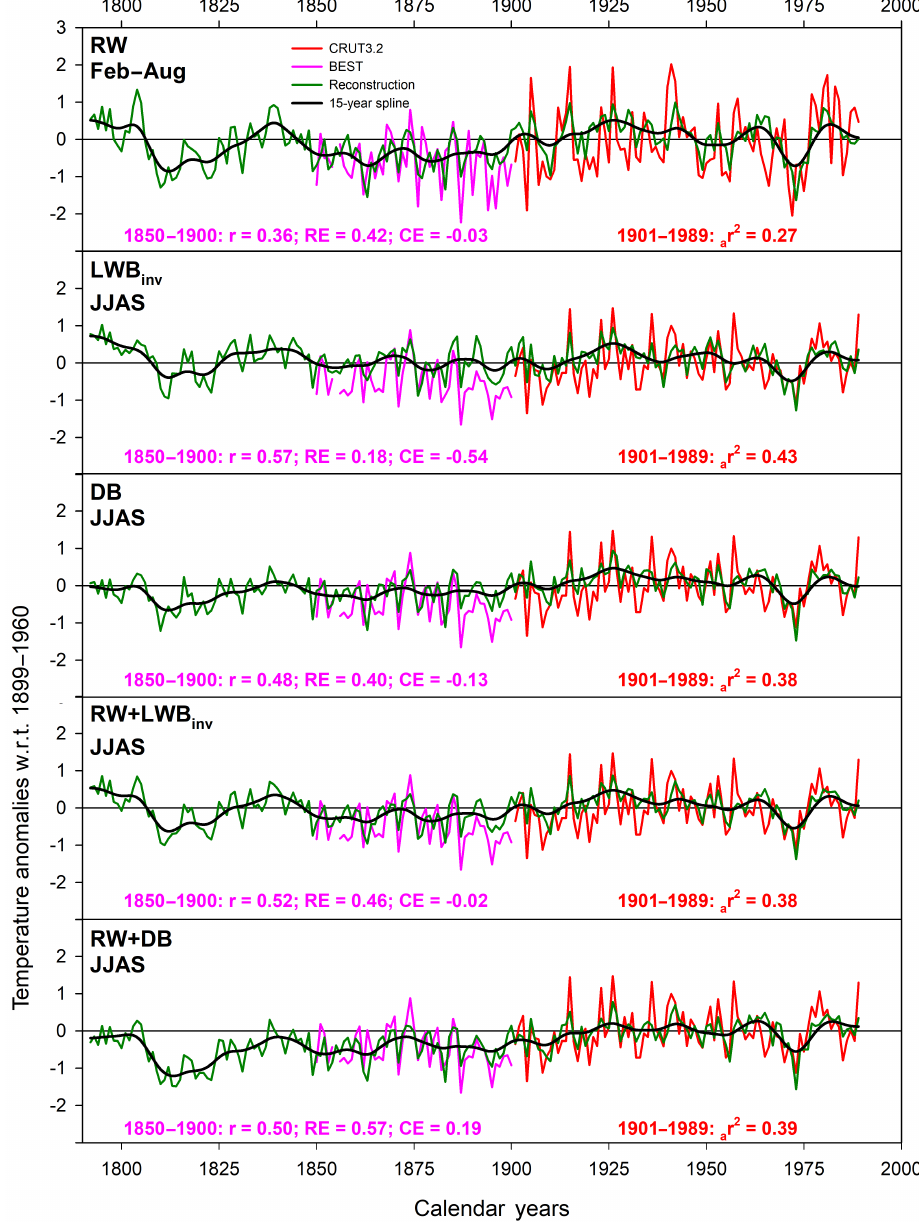
Figure 3. Illustration of the various PC regression experiments performed herein, with each reconstruction model compared with June– September (Table 3). February–August is shown for RW as that was the reconstructed season in Wiles et al. (2014). Full period calibration is performed on the 1901–1989 period (Table 3 – CRU TS 3.24) while validation (Pearson’s correlation coefficient, r ; reduction of error, RE; and coefficient of efficiency, CE) is undertaken over 1850–1900 using the BEST gridded data after those data were scaled to the CRU TS 3.24 data over the 1901–1989